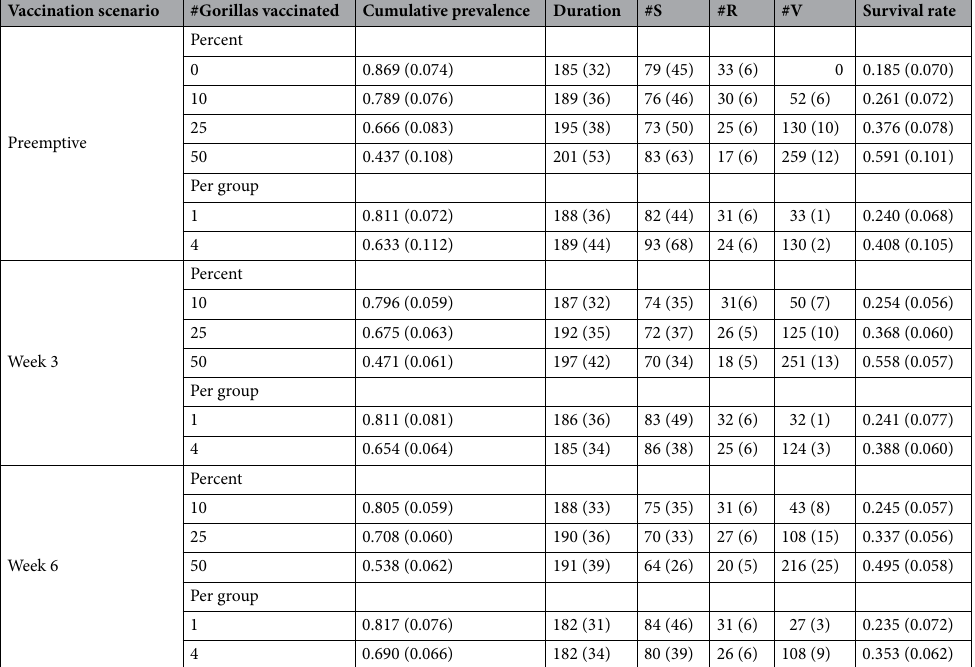
Table 2. Summary impacts of a modeled Ebola virus outbreak entering the Virunga Massif population of mountain gorillas via one exposed gorilla in the DRC-1 group, under various vaccination strategies. Preemptive = gorillas vaccinated prior to arrival of the first Ebola case; Week 3 = vaccinations administered 3 weeks after the first case becomes infectious; Week 6 = vaccinations administered 6 weeks after the first Infectious individual. # Gorillas Vaccinated was either applied randomly to a percent of the habituated gorillas or applied to 1 or 4 gorillas in each of the 33 habituated groups. #V is the number that were effectively vaccinated (resulting in protective immunity), i.e., not including the 3% for which the vaccine was not effective; other columns as in Table 1. Presented as mean (SD); SD = standard deviation across 500 iterations.